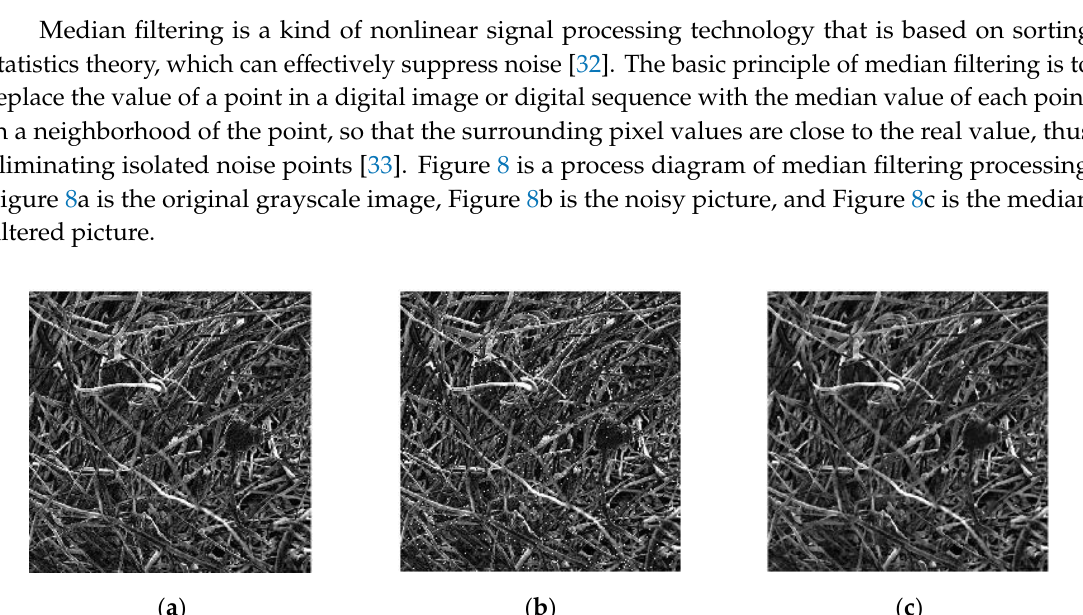
Figure 7. The gray scale image and grayscale histogram before and after grayscale stretching: ( a1 ) Original grayscale image ( a2 ) Original grayscale histogram ( b1 ) Grayscale stretch effect image ( b2 ) Histogram of grayscale stretched image.